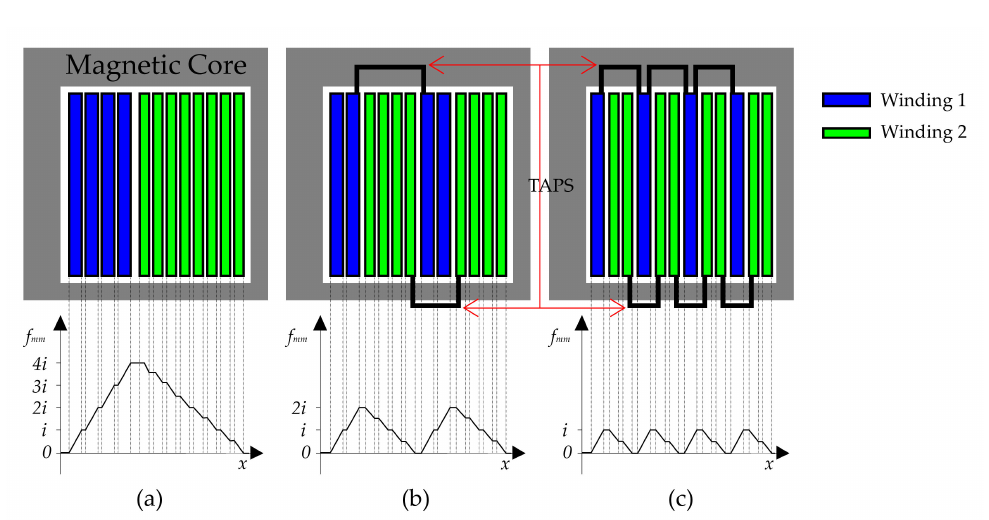
Figure 10. Magnetomotive force distributions for different winding configurations: ( a ) non-interleaved; ( b ) partially interleaved; ( c ) fully